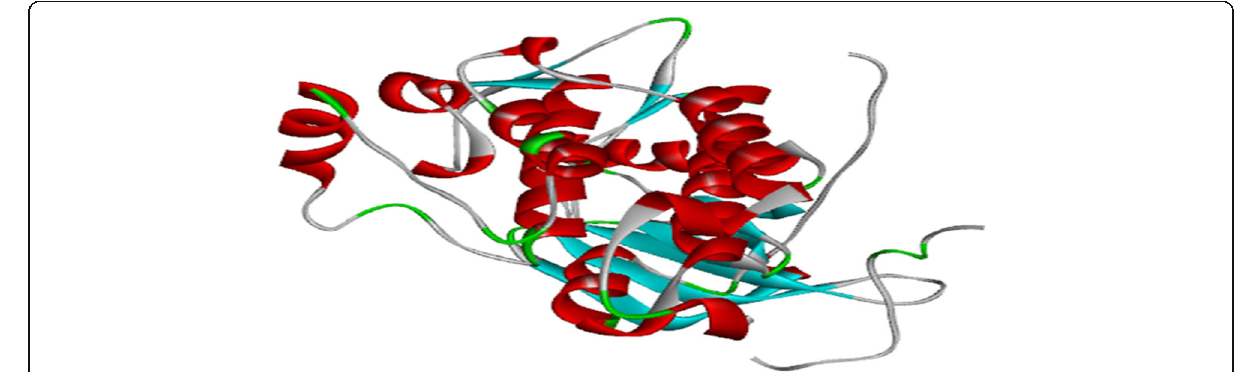
Fig. 2 3D structure of the prepared EGFR tyrosine kinase